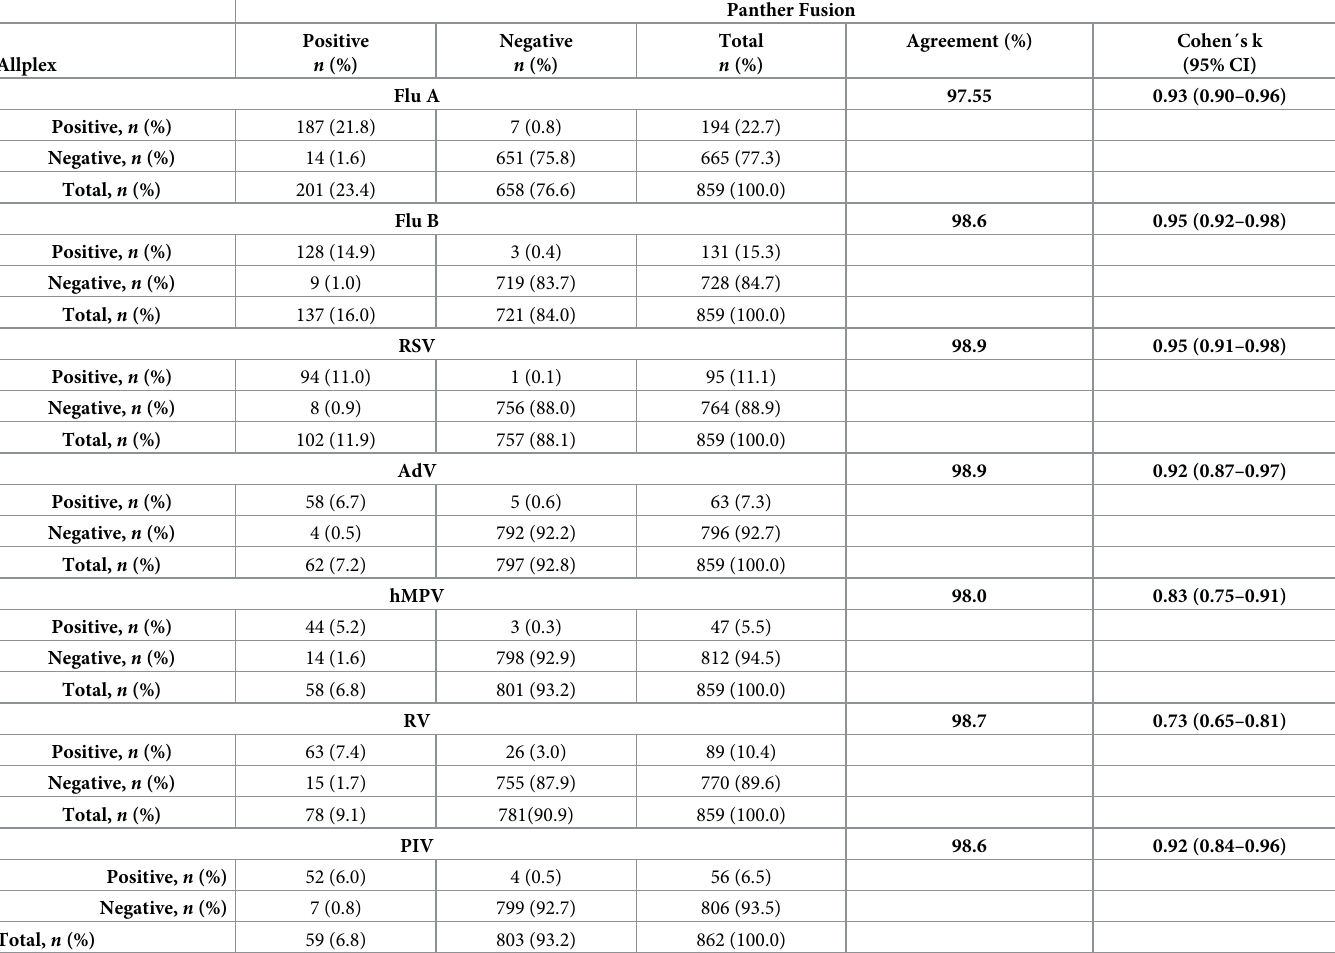
Table 5. Performance of Allplex and Panther Fusion systems for each viral target analyzed in both retrospective and prospective studies.